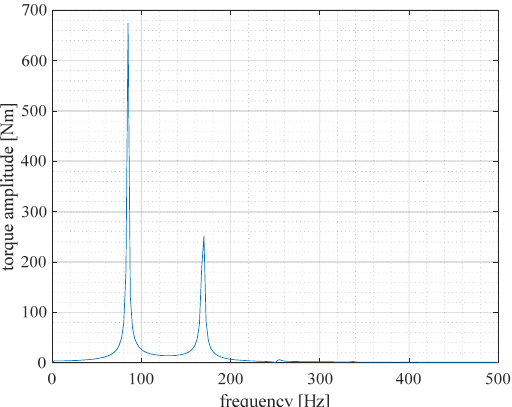
Figure 11. Dominant harmonics of ICE torque and its Fourier analysis results.